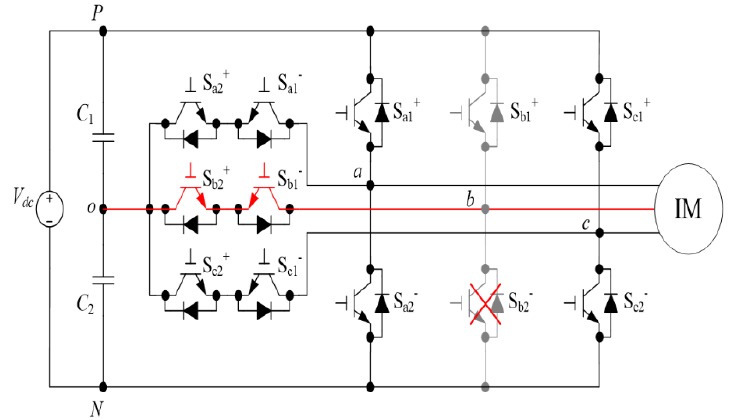
Figure 15. FTC for the occurrence of an open-circuit fault in S b 2 −